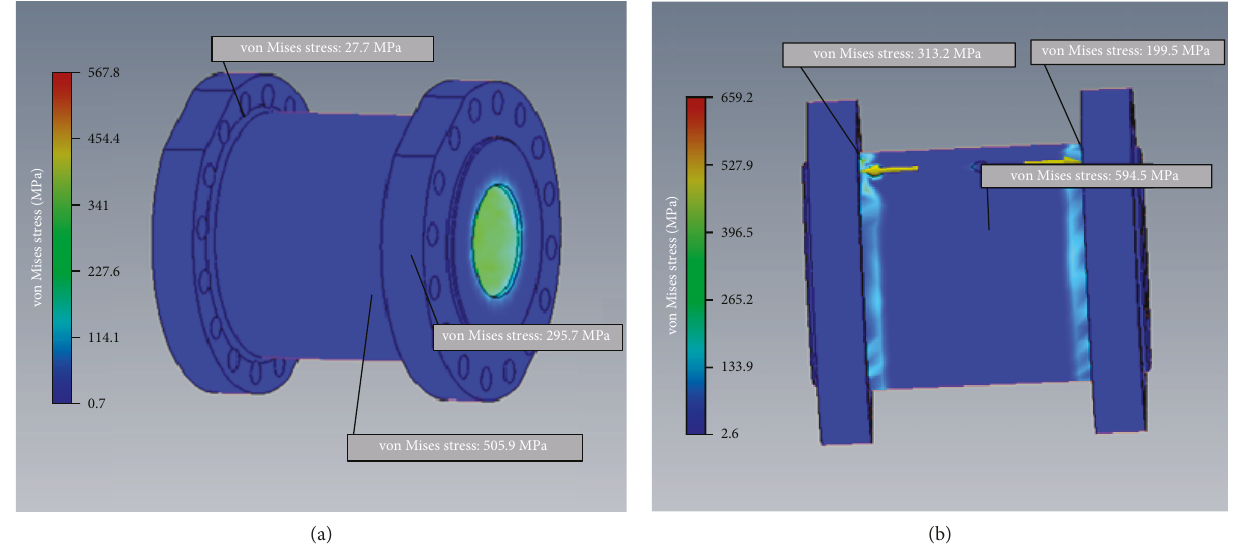
Figure 7: von Mises stress distribution in the cylinder. (a) Con fi guration of the pull rod. (b) Assembled con fi